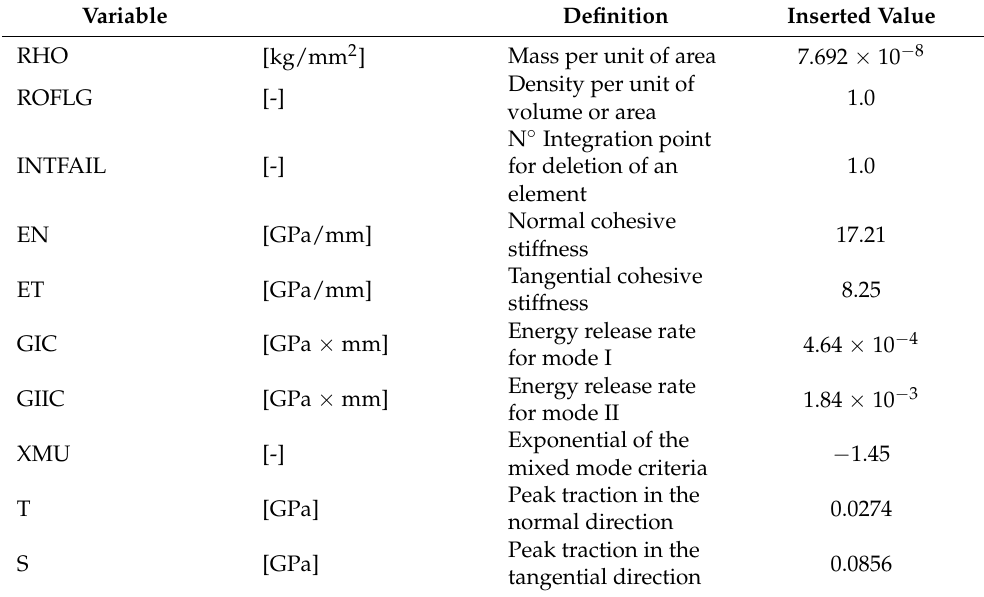
Table 5. MAT20 standard material parameters for rigid aluminum ASTM impactor.